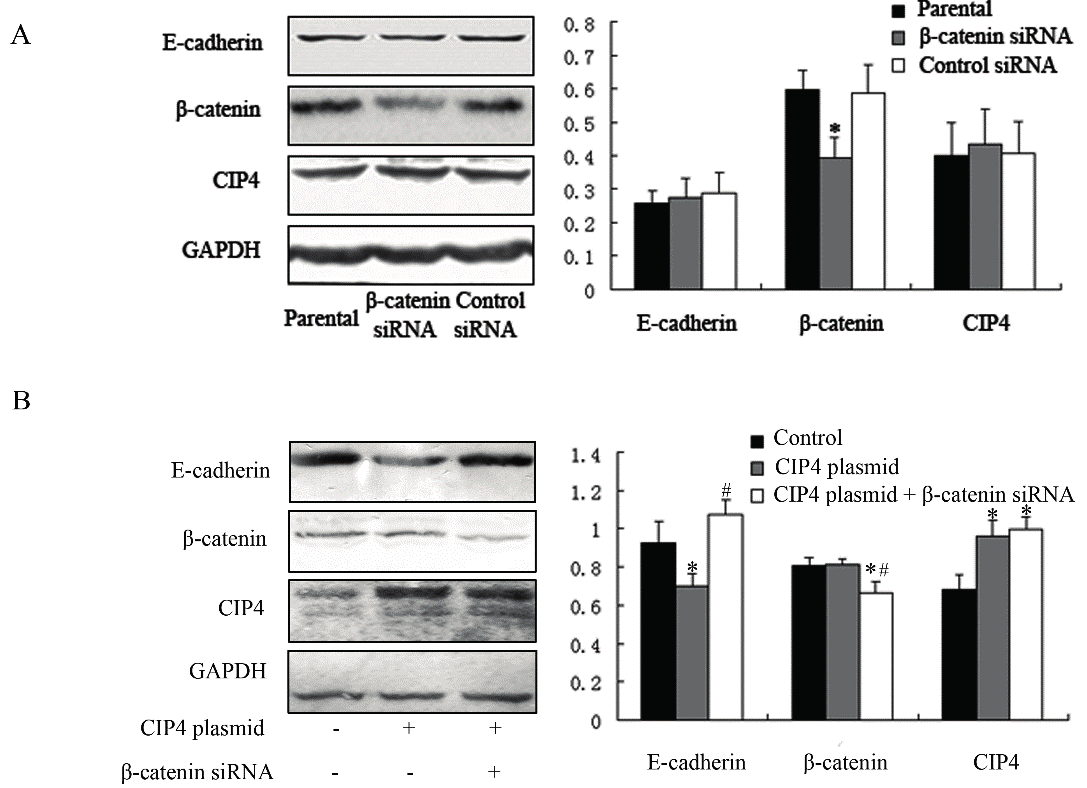
Figure 5. CIP4 regulates E-cadherin expression through β -catenin. ( A ) Western blots for protein expression of E-cadherin, β -catenin, and CIP4 in parental, β -catenin siRNA-transfected, and control siRNA-transfected cells; Cells overexpressing CIP4 were transfected with β -catenin siRNA for β -catenin depletion and cell lysates were analyzed by ( B ) Western blot for protein expression of E-cadherin, β -catenin and CIP4. The histograms show the average volume density normalized to the loading control GAPDH ( n = 3); * p < 0.05 compared with parental cells; # p < 0.05 compared with CIP4 plasmid-transfected